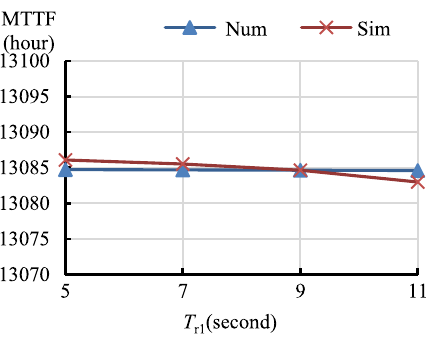
Fig. 6 Comparison of numerical results and simulation results for MTTF